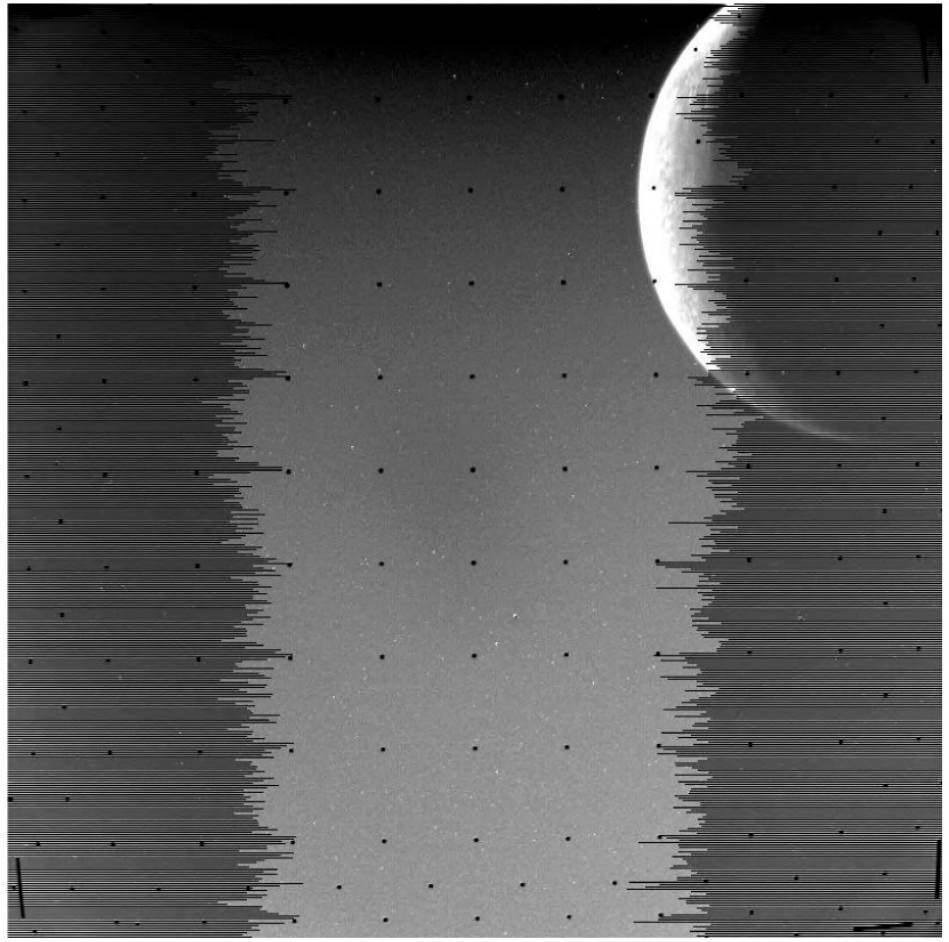
Figure 5. Reseaux marks (dark spots) and line dropouts in compressed Voyager images of Triton. Image ID c1140959.imq. Reseaux marks occur in all